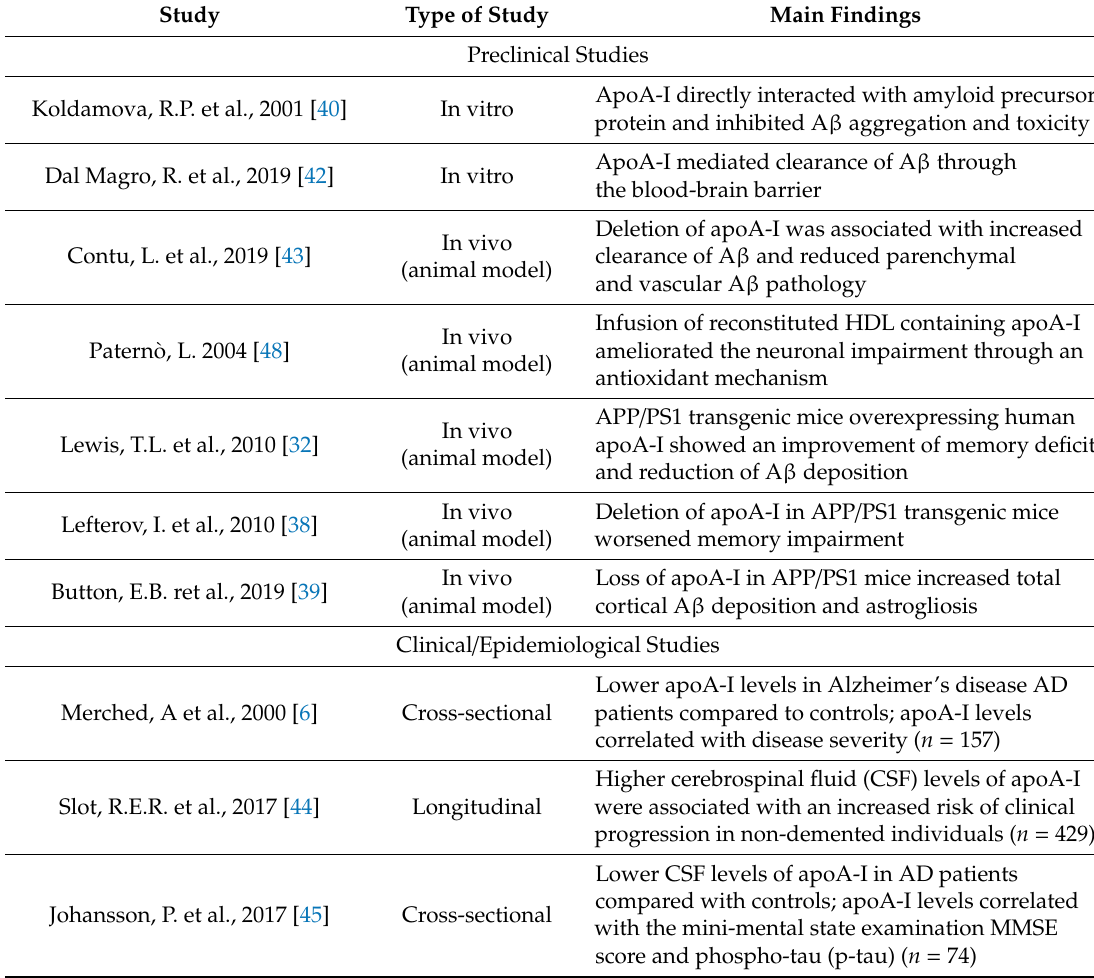
Table 1. Selection of preclinical and clinical evidence supporting the role of apolipoprotein A-I (apoA-I) in protecting from Alzheimer’s disease